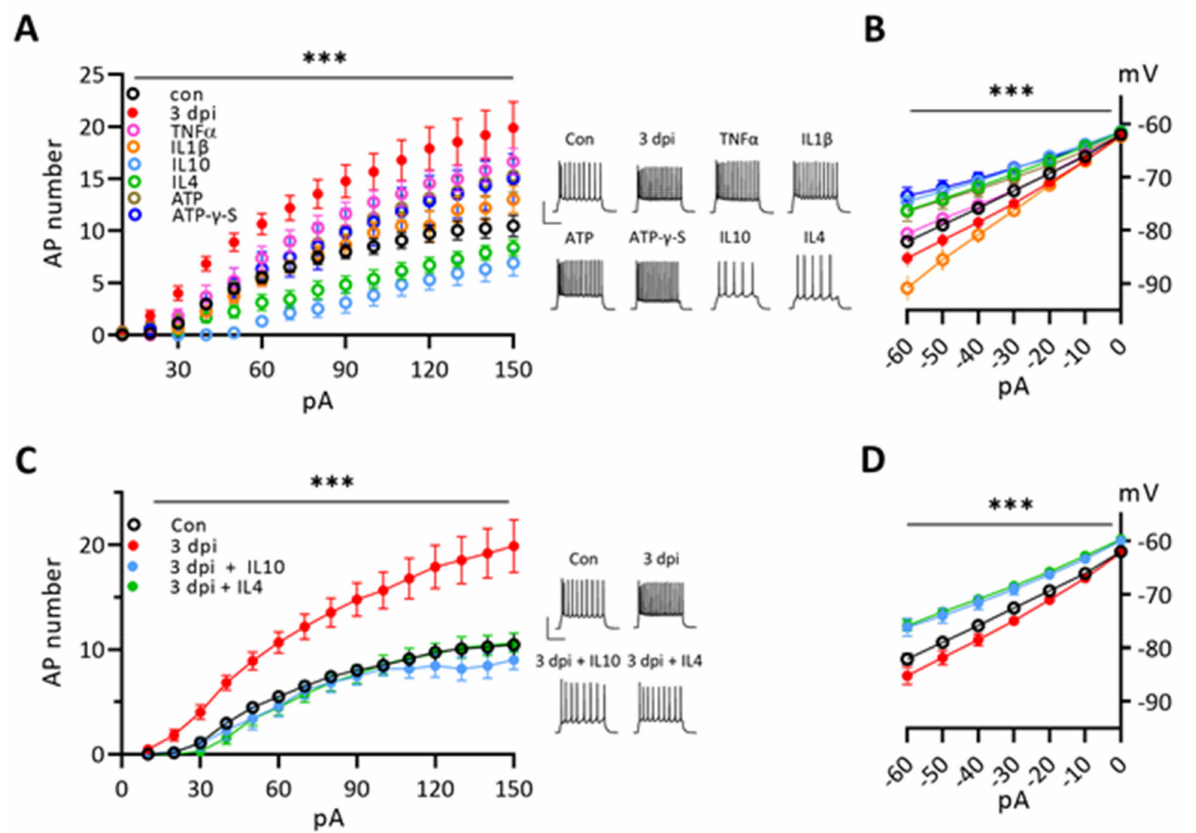
Figure 5. Effects of cytokine and ATP on the excitabilities of naïve neurons and 3 dpi neurons. Two-way ANOVA with Tukey’s test for comparing the experimental group to the control group (***, p < 0.001). ( A ). Effects of each cytokine and ATP on the number of action potential firings of naïve neurons to 500 msec depolarization pulses compared with those of naïve controls and 3 dpi neurons. Each cytokine (10 ng/mL), ATP (1 mM), ATP- γ -S (100 µ M). Two-way ANOVA with Tukey’s test. Insets , Example traces of cortical neuron firing to +120 pA current injection under each conditions. Scale bars , 50 mV and 200 ms. The same color and symbol of each condition are used in ( A , B ). ( B ). Effects of each cytokine and ATP on I–V plot of naïve neurons to hyperpolarizing current steps compared with naïve controls and 3 dpi neurons. Two-way ANOVA with Tukey’s test. ( C ). Effects of IL-10 and IL-4 on the action potential firing numbers of 3 dpi neurons compared to naïve controls. Two-way ANOVA with Tukey’s test. Insets and scale bars , the same conditions in ( A ). The same color and symbol of each condition are used in ( C , D ). ( D ). Effects of IL-10 and IL-4 on I–V plot of 3 dpi neurons to hyperpolarizing current steps compared with naïve controls. Two-way ANOVA with Tukey’s